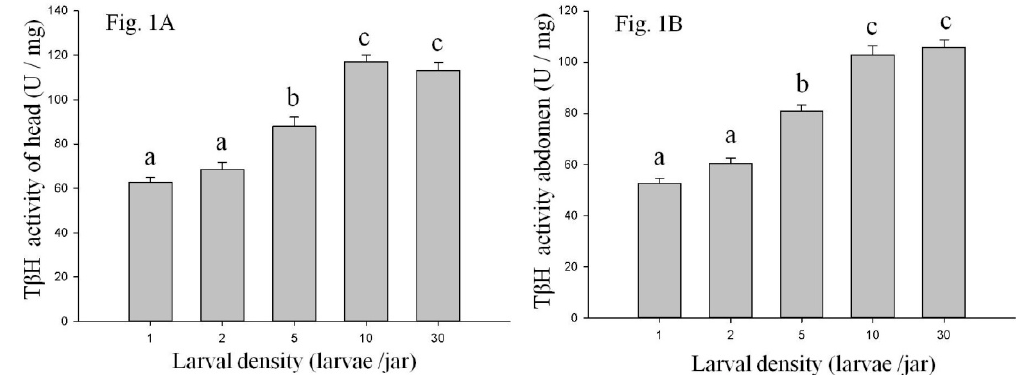
Figure 1. The activity of tyramine β -hydroxylase enzyme of M. separate head ( A ) and abdomen ( B ) among larvae reared at one, two, five, 10, and 30 larvae per jar. Data are presented as the mean ± SE, n = 3. Different characters denote significant difference at p < 0.05.